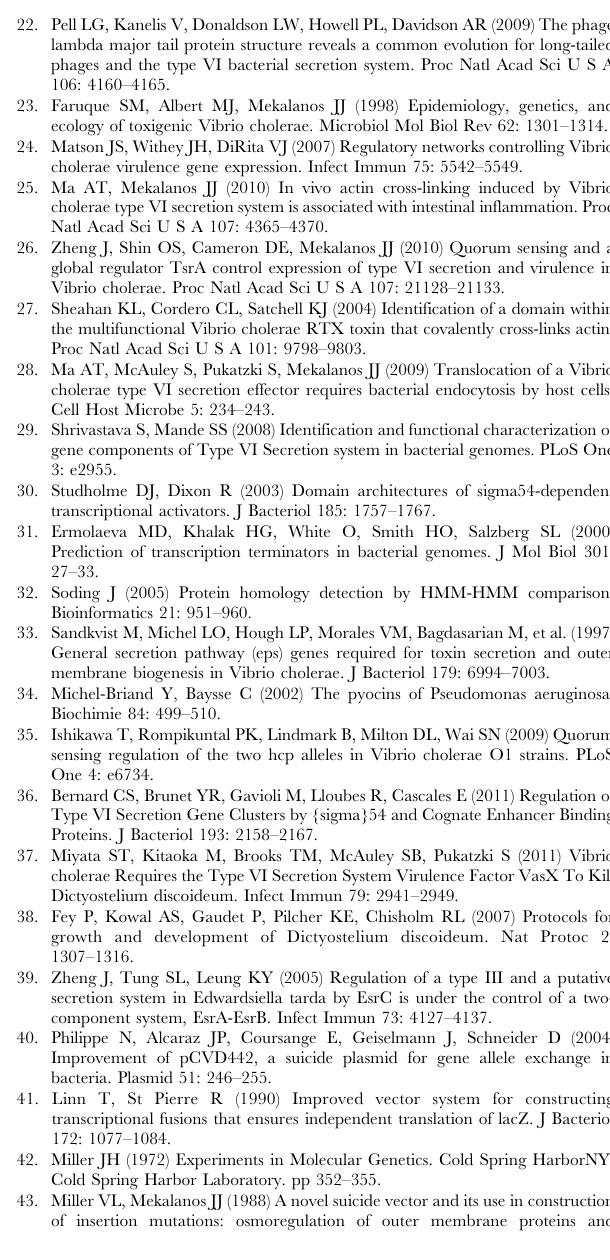
Table S3 The first ten hits of VCA0021 analyzed by HHPRED. (DOC) Table S4 Primers used for non-polar deletion mutants in this